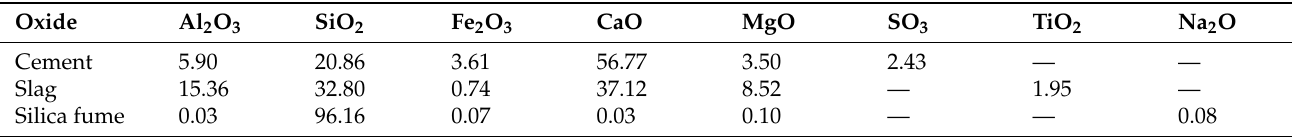
Table 6. Chemical composition of cement, slag, and silica fume